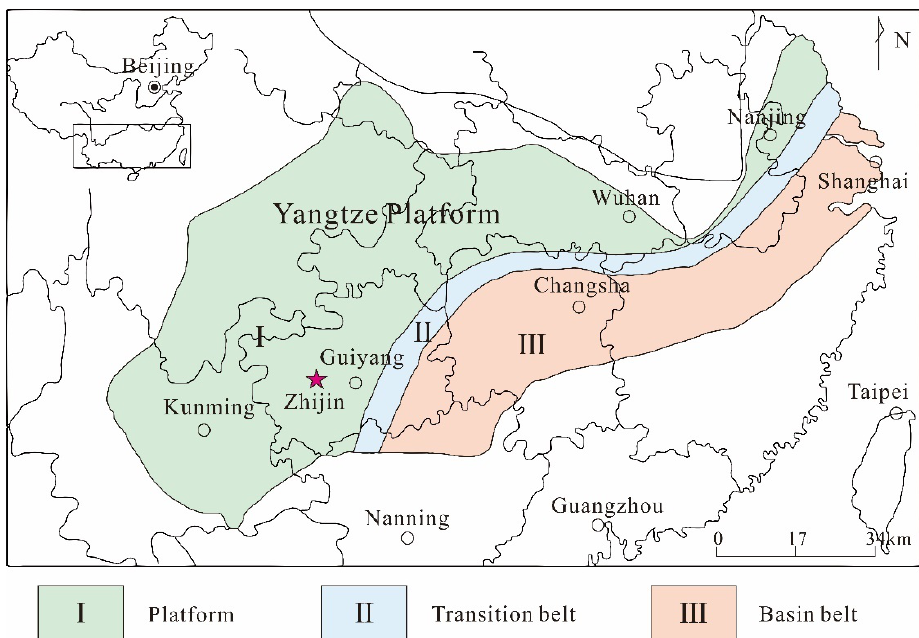
Figure 1. Simplified paleogeographic map of the Yangtze Platform during the early Cambrian, mod- ified from Steiner et al. (2001) [34] and Guo et al. (2007) [32]. The star represents the studied region. Xinhua and Lijiazhai phosphate ore blocks are two typical ore blocks in the Zhijin deposit. The LFC section, the Gaoshan (GS) section, and the ZKX002 section belong to the Xinhua phosphate ore block, and the Lijiazhai (LJZ) section belongs to the Lijiazhai phosphate ore block (Figure 2a). The Lijiazhai ore block is 17 km to the southeast of the Xinhua ore block (Figure 2a). In the Zhijin region, the phosphate rocks of the early Cambrian Gezhongwu Formation conformably overlay the dolomite of the Dengying Formation and are in turn, conformably overlain by the siltstone of the Niutitang Formation and equivalent strata (Figure 2b).